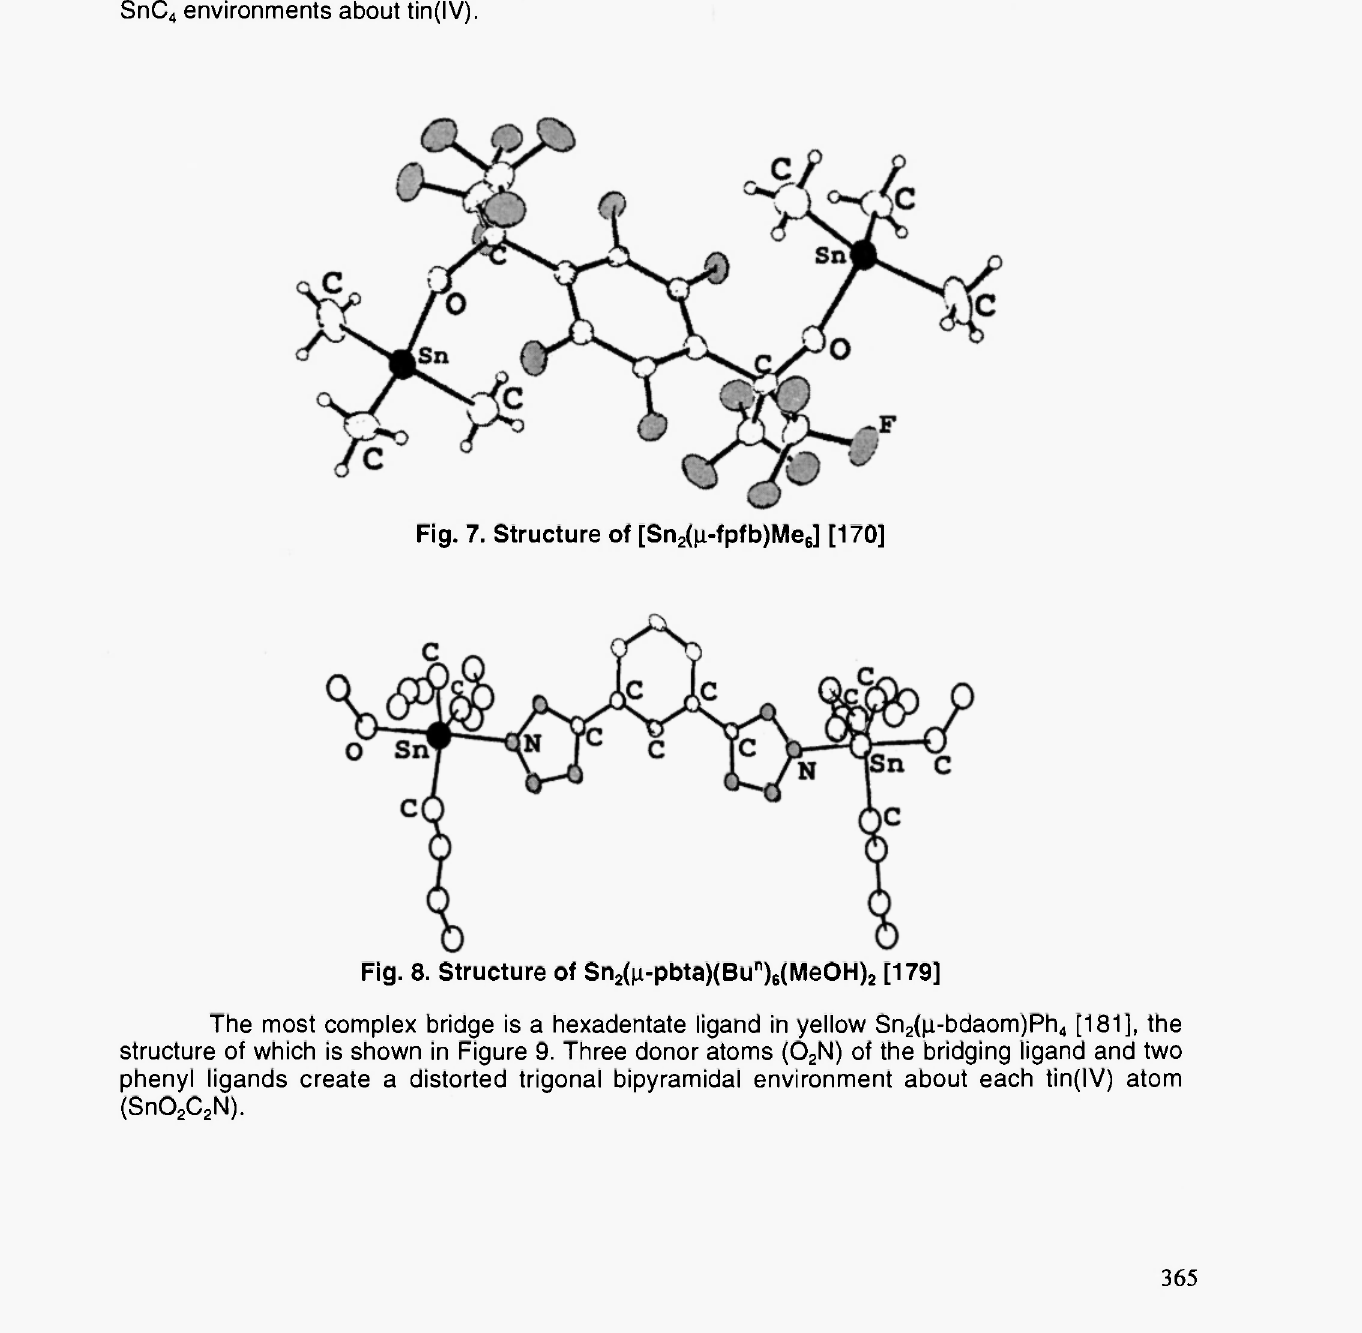
Fig. 8. Structure of Sn 2 ^-pbta)(Bu n ) 6 (MeOH) 2